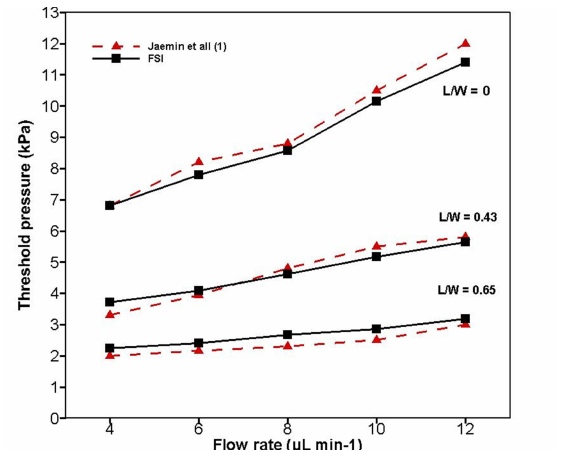
Figure 6. Comparison of experimental results with fluid-structure interaction (FSI) results for changes in opening threshold pressure against change in flow rate.